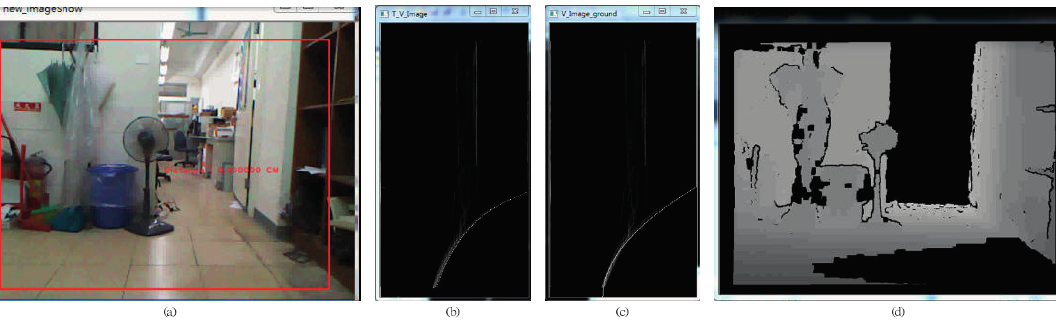
Figure 8. The scene with people. ( a ) Real scene; ( b ) V-disparity; ( c ) Depth map.